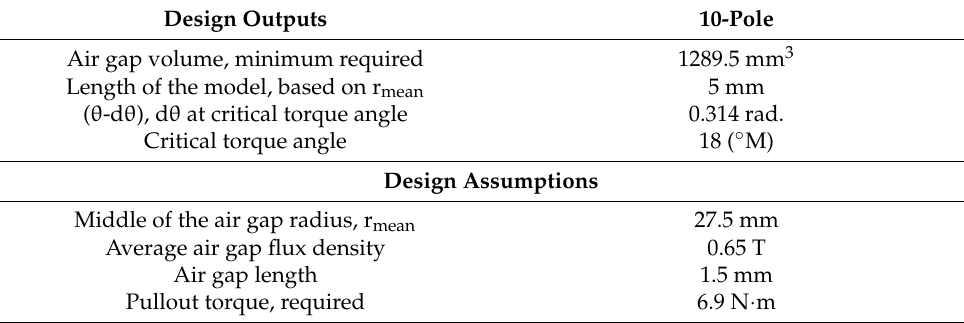
Table 2. Analytical design calculations by virtual work approach for preliminary sizing.